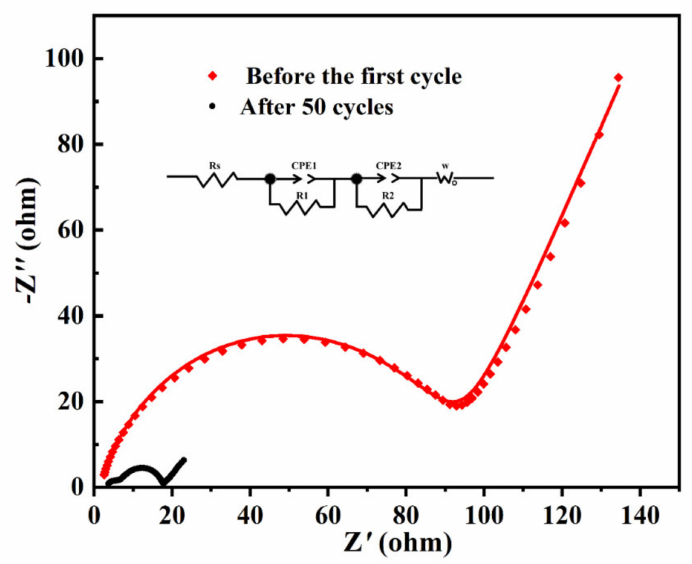
Figure 7. EIS of MoO 2 /C nanofibers before the first cycle and after the 50th cycle. Inset is the equivalent electrical